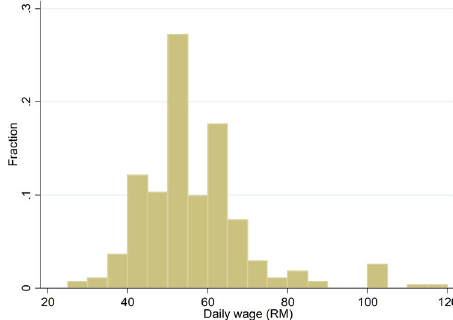
Fig. 7 Distribution of daily wages (RM). Respondents distribution by daily wage (RM).